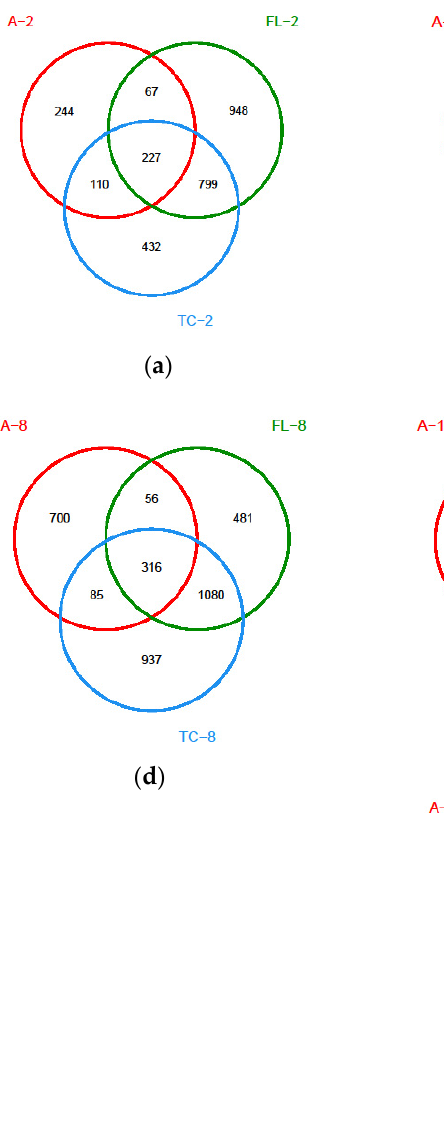
Figure 7. Community structure components of air ( a ), foreleg ( b ), and thorax ( c ) microorganisms at the genus level.